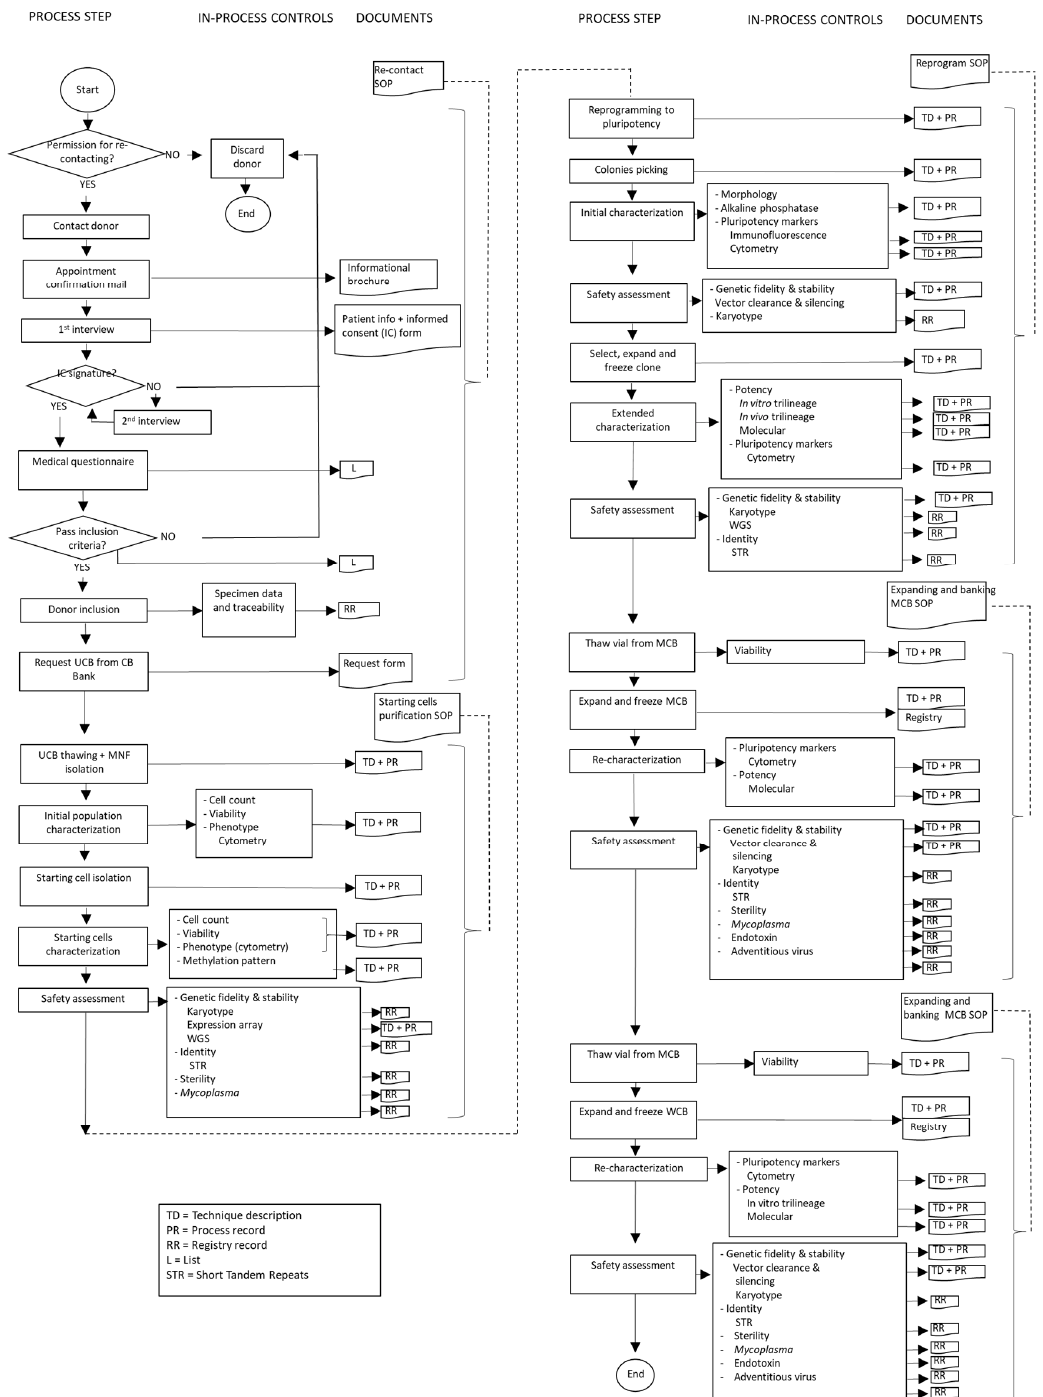
Figure 2. Flow chart of building an iPSCB from CBB and associated SOP and records.